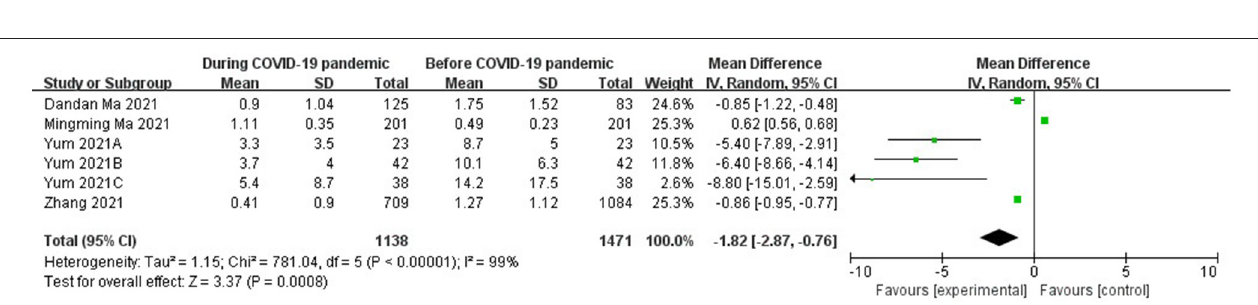
Frontiers in Public Health | www.frontiersin.org 6 July 2022 | Volume 10 | Article